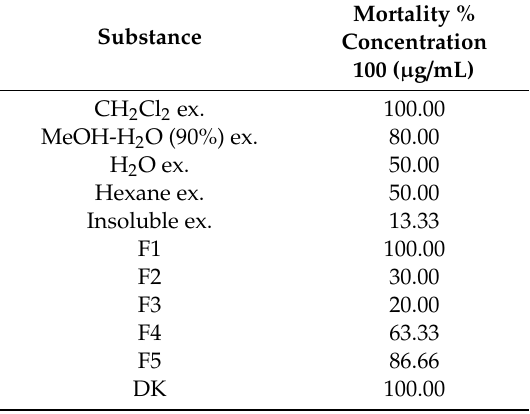
Table 2. Bioactivity evaluation of A. zerumbet extracts / fractions using brine shrimp